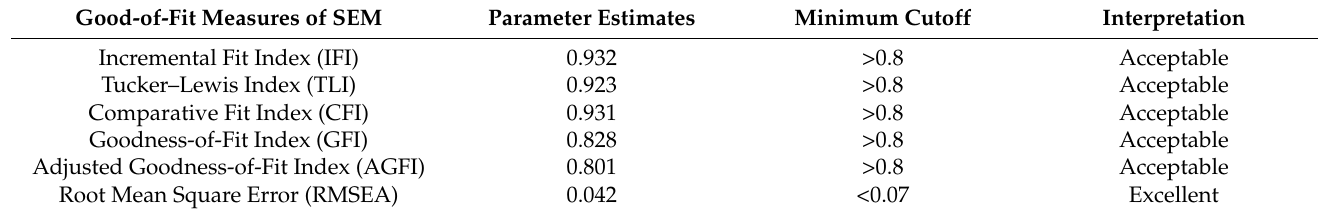
Table 5. Model fit.